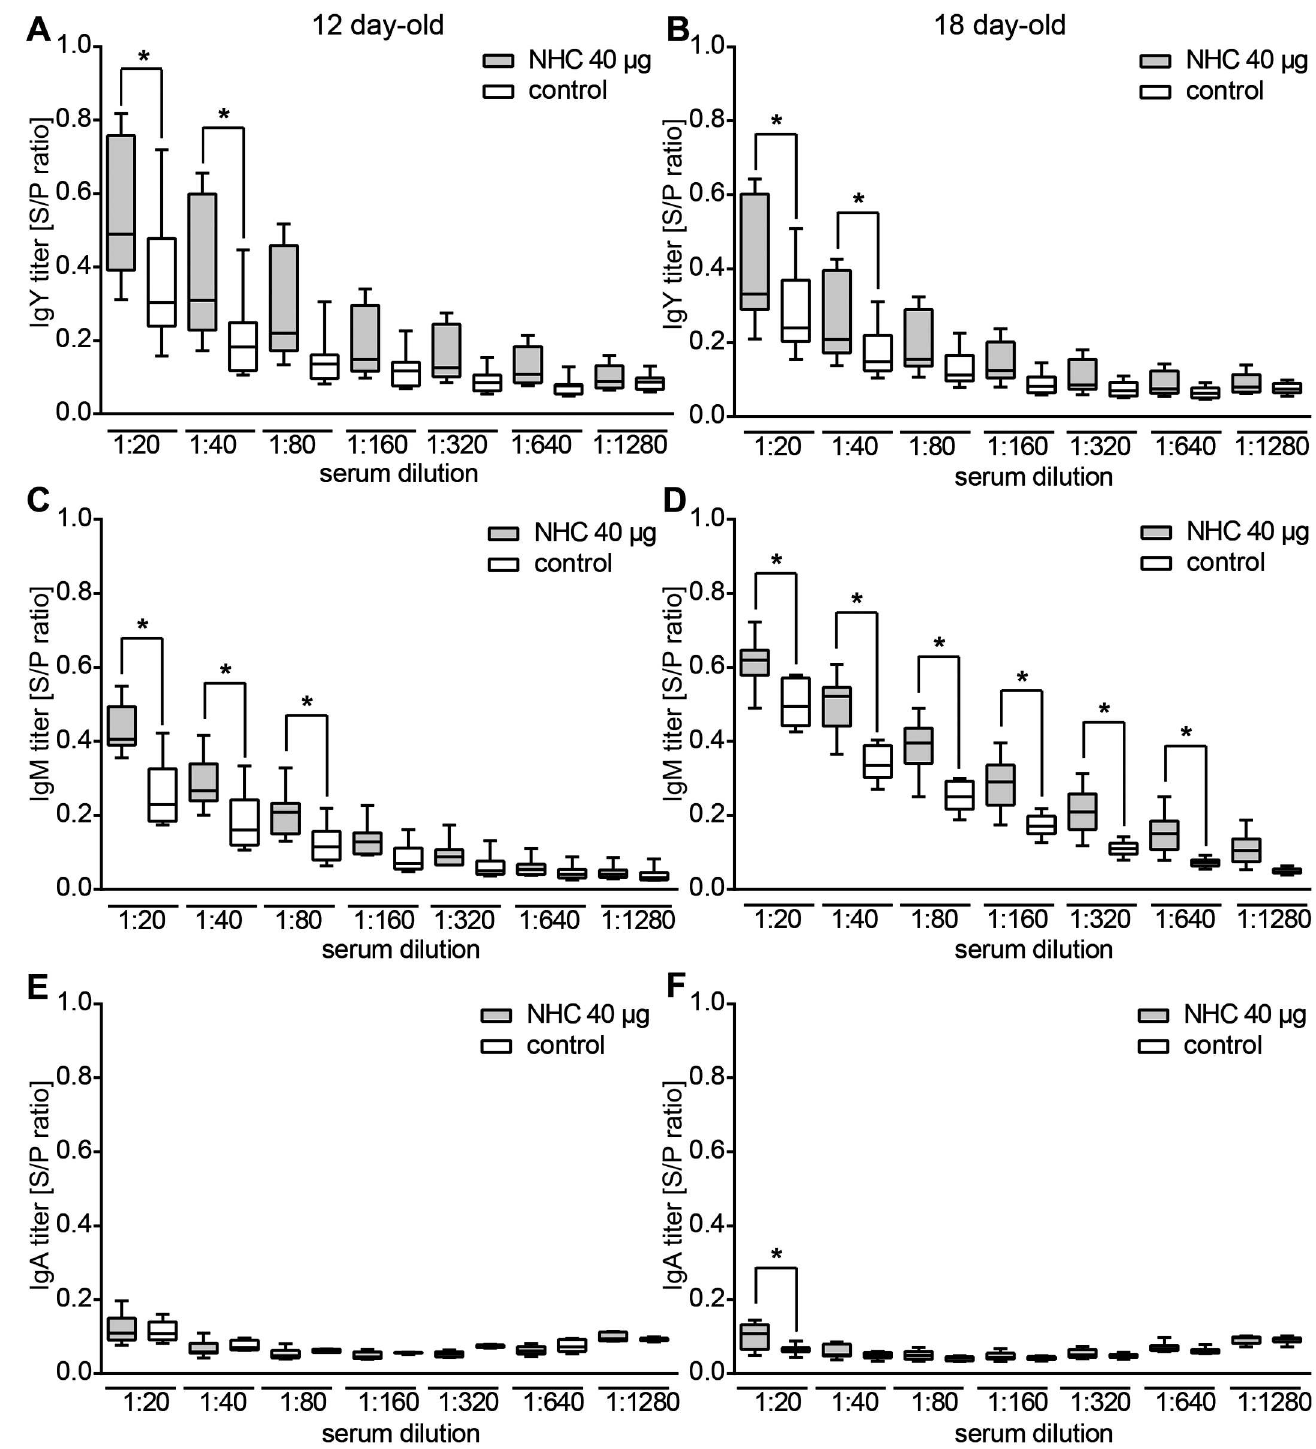
Fig 4. Kinetics of NHC-specific antibody levels following in ovo vaccination. ELISA results demonstrating the NHC flagellin-specific reactivity of serially diluted sera collected from ( A , C , E ) 12 day-old and ( B , D , F ) 18 day-old chickens injected with 40 μ g of NHC flagellin or solvent (control). Serum IgY ( A , B ), IgM ( C , D ) and IgA ( E , F ) antibody responses are indicated.Graphs represent the analysisof individualanimals, displayedas a box-and-whisker plot. The amount of antigen-specific antibodieswas expressed in a relation to the reference sera (S/R, sample to reference ratio). An asterisk indicates statistically significant differences ( α < 0.05) between